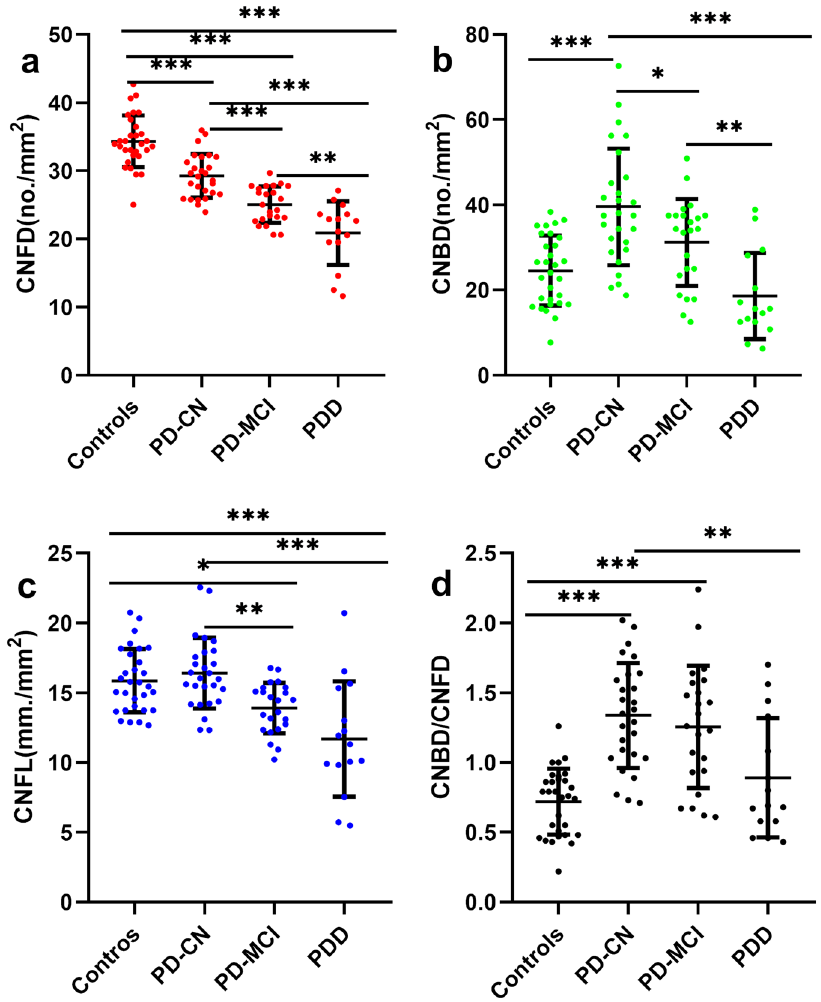
Fig. 3 CCM parameters in healthy controls and PD patients with a varying degree of cognitive dysfunction. CNFD, CNBD, CNFL, and CNBD/CNFD ratio in PD-CN, PD-MCI, and PDD group were compared with that in the control group and dot plots were generated. CNFD decreased with cognitive decline ( a ). CNBD, CNFL and CNBD/CNFD radio was increased in PD-CN compared to controls with a trend for a decrease with cognitive impairment in PD ( b – d ). Multiple comparisons were performed using analysis of variance (ANOVA) with Bonferroni as post hoc test and Kruskal – Wallis test. Errors bars represent mean ± standard deviation ( *P < 0.05, ** P < 0.01, * ** P < 0.001). Abbreviations: PD Parkinson ’ s disease, PD-CN Parkinson ’ s disease with cognitively normal, PD-MCI Parkinson ’ s disease with mild cognitive impairment,